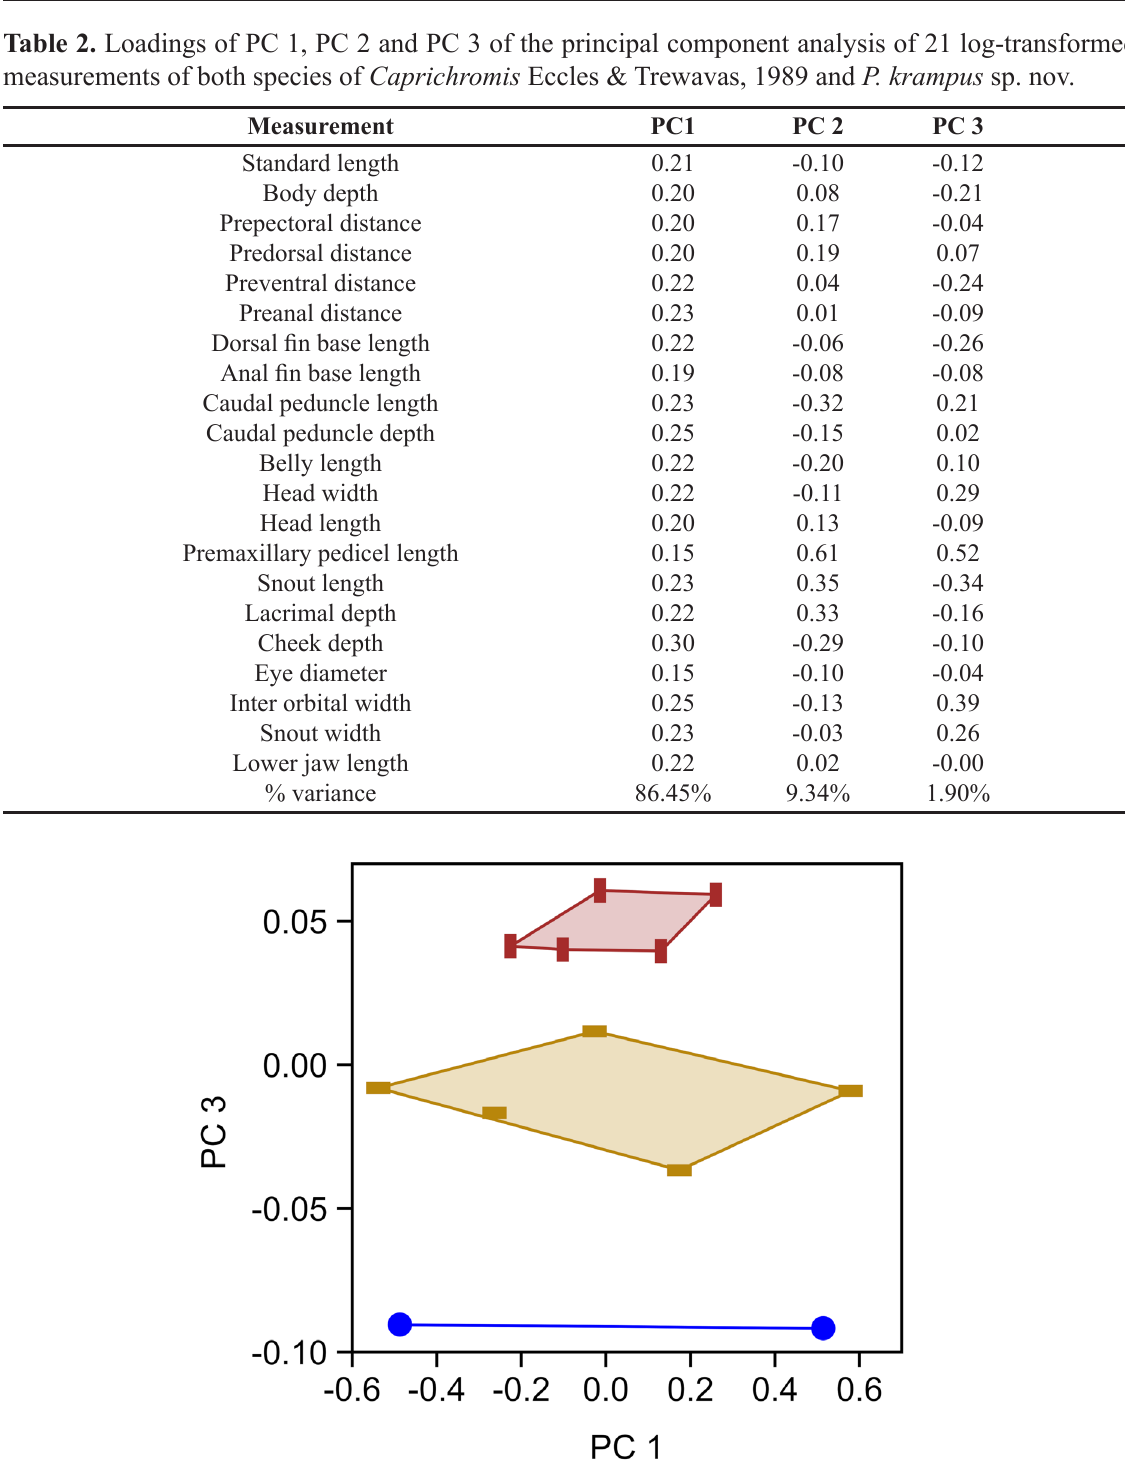
Fig. 2. Scatter plot of PC 1 against PC 3 for a principal component analysis of 21 log-transformed measurements of Protomelas krampus sp. nov., Caprichromis liemi (McKaye & Mackenzie, 1982) and C. orthognathus (Trewavas, 1935) (n = 12). P. krampus sp. nov. = blue dot; C. liemi = light brown dash; C. orthognathus = dark brown